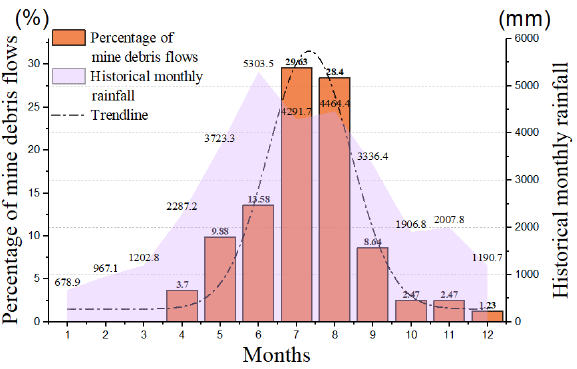
Figure 1. Distribution of major mine debris flows by month over the years.